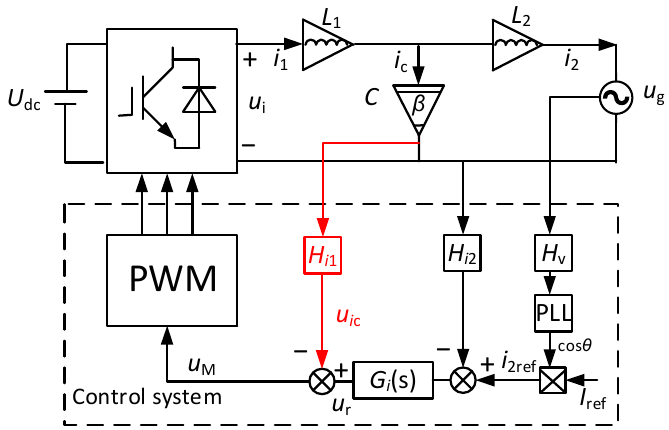
Figure 5. System structure of the single-phase FOGCI (Capacitor current proportional feedback can be eliminated if α + β ≠ 2).